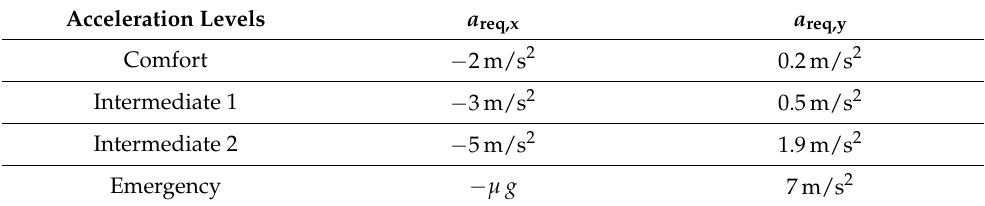
Table 2. Acceleration levels for lateral and longitudinal movement.